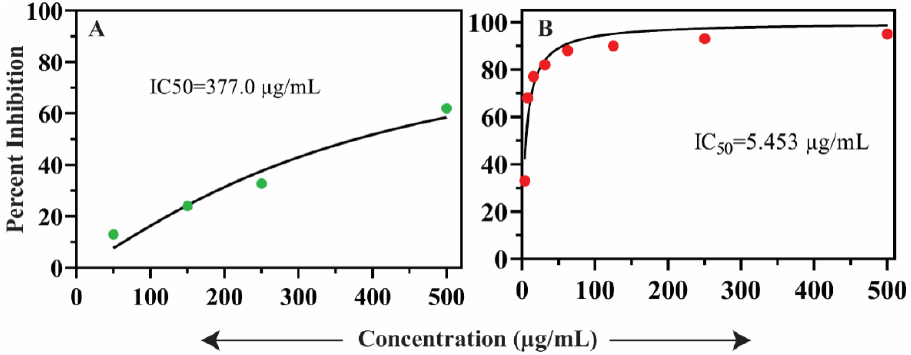
Figure 5. % inhibition of α -glucosidase activity ( A ) oil of S. edelbergii and ( B ) acarbose (standard).